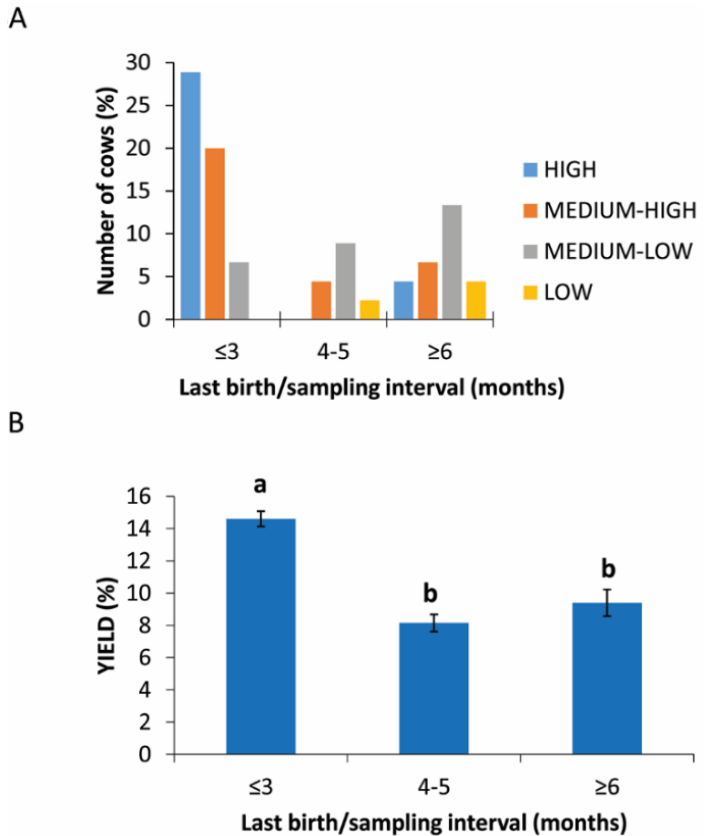
Figure 3. PRP yield in different intervals between the last birth and sample collection. ( A ) Distribution (%) of cows in different last birth/sampling intervals expressed in months in the different PRP yield classes. ( B ) Comparison of PRP yield among different groups based on last birth/sampling intervals expressed in months. Values are expressed as means and standard deviations. Different letters represent statistically significant differences.